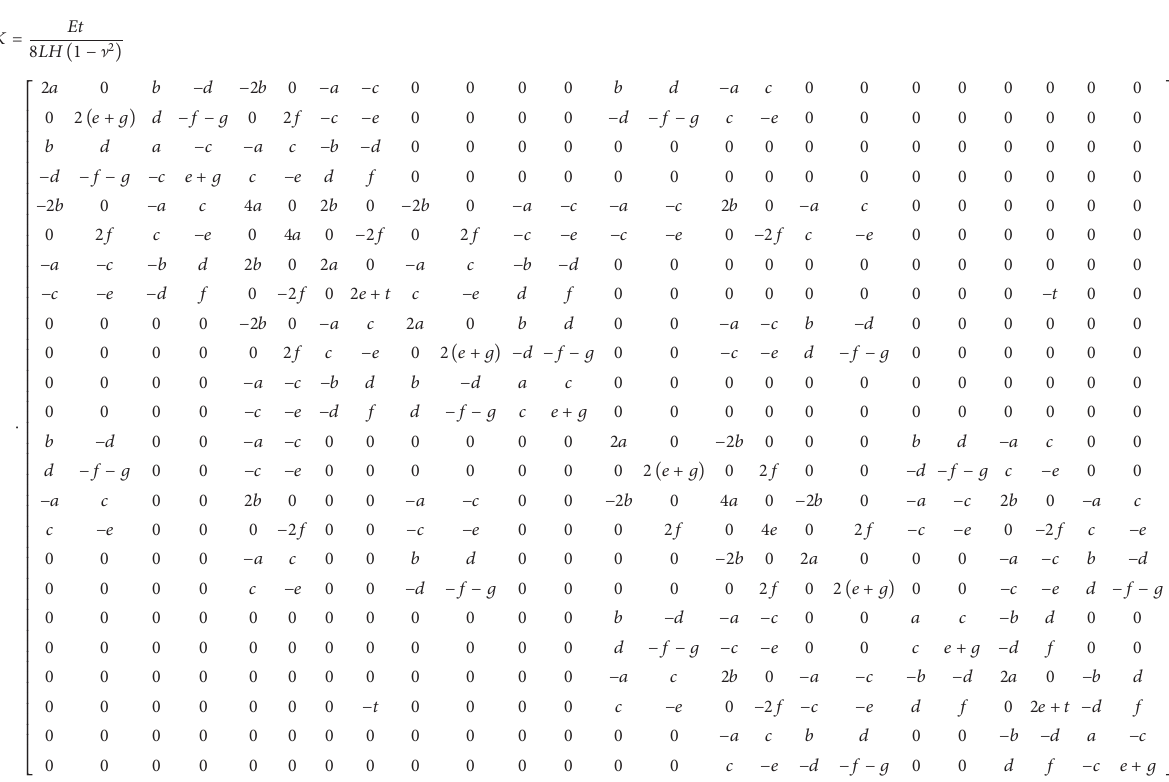
Table 4 represents the percentage difference between two types of analysis on two concrete segments. In plane stress analysis, maximum displacements of 74.46 mm for the pro- posed constitutive model and 73.94 mm in FE program are achieved subjected to applied load. Likewise, in plane strain analysis, applied forces produce 191.21 mm and 194.19 mm displacements by proposed constitutive model and FE model, respectively. Table 4 shows almost 0.65% difference between two approaches in plane stress analysis for different